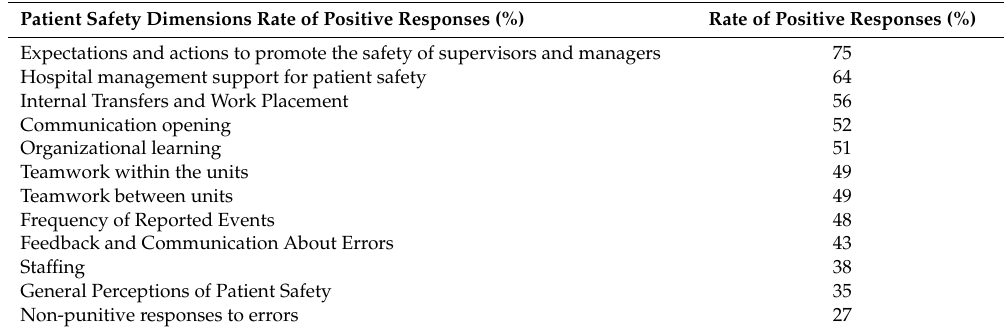
Table 2. Distribution of the positive response rate of health professionals according to the Dimensions of Patient Safety in the Network of Psychosocial Care of the Municipality of Rio Branco, 2017.